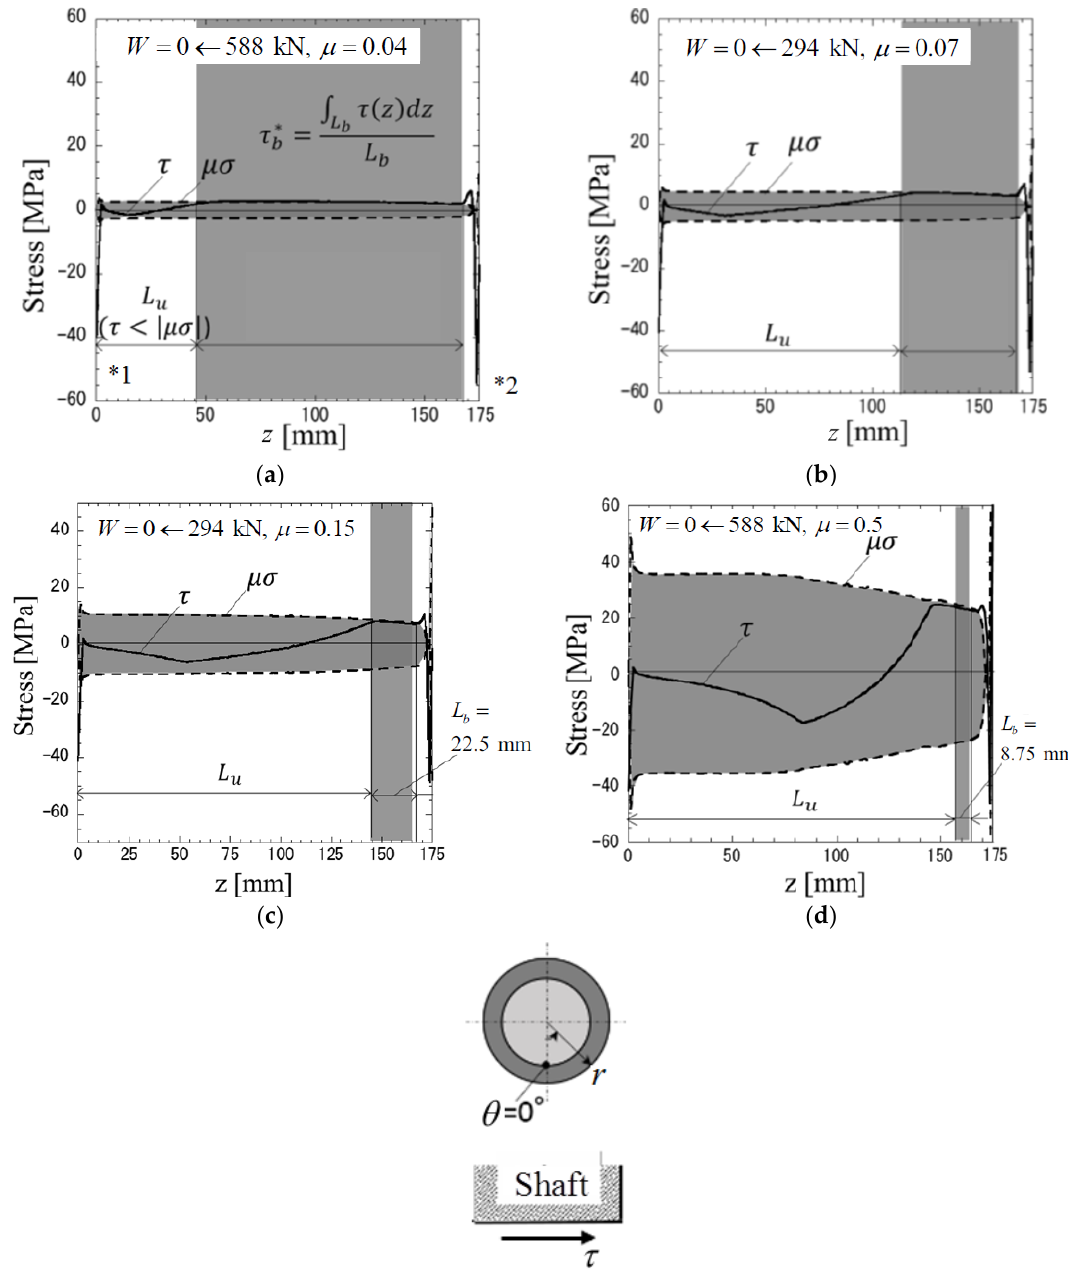
Figure 9. Shear stress τ and frictional stress µσ along shaft surface contacted with sleeve after unloaded; ( a ) Point a, W = 0 ← 588 kN, µ = 0.04; ( b ) Point b, W = 0 ← 294 kN, µ = 0.07; ( c ) Point c, W = 0 ← 294 kN, µ = 0.15; ( d ) Point d, W = 0 ← 588 kN, µ = 0.5 (*1: Error due to boundary condition, *2: Error due to end effect and boundary